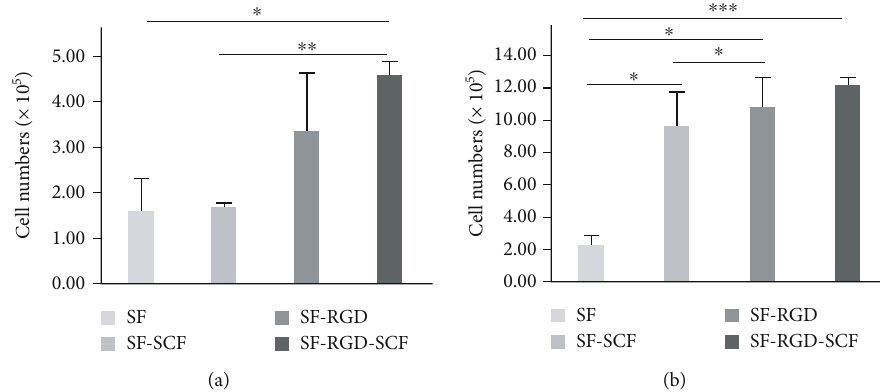
Figure 5: Cell numbers after 1 and 7 d cell seeding: (a) 1 d; (b) 7d. Data are means with SD error bars in ( n = 3 ). ∗ P < 0 : 05 , ∗∗ P < 0 : 01 , ∗∗∗ P < 0 : 001